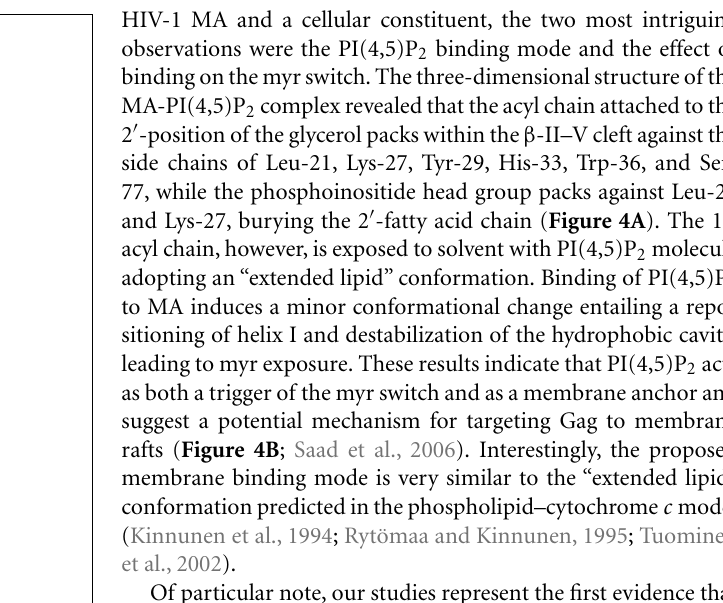
FIGURE 4 | (A) Representation of the PI(4,5)P 2 molecule (phosphate groups are shown as yellow balls), and (B) membrane binding model predicted from the structural studies; the exposed 1 (cid:2) -fatty acid chains (yellow) and myristyl groups (green) project from a highly basic surface (basic side chains shown in blue) in a manner expected to synergistically promote membrane binding. [ (B) is reprinted from Saad et al., 2006; Copyright, Michael F. Summers, used with